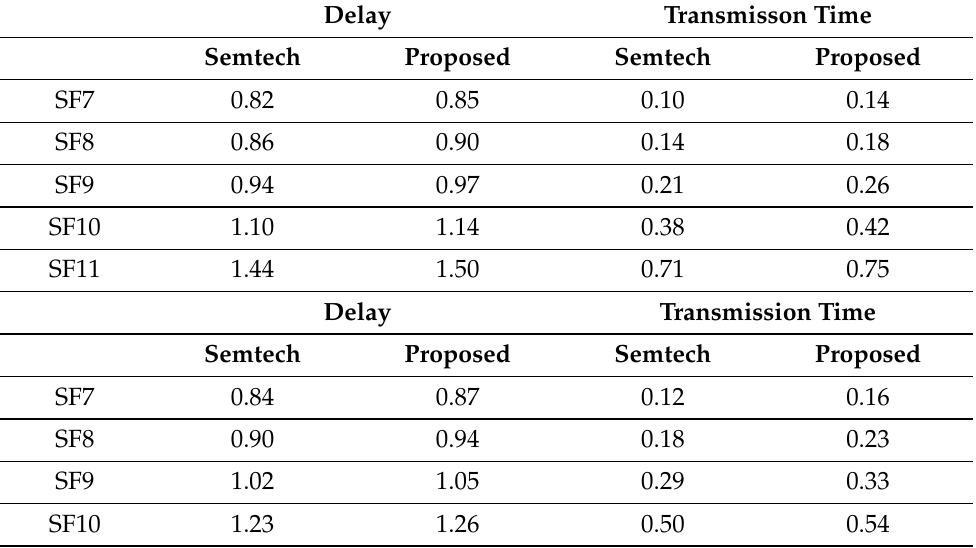
Table 8. Delay and transmission time